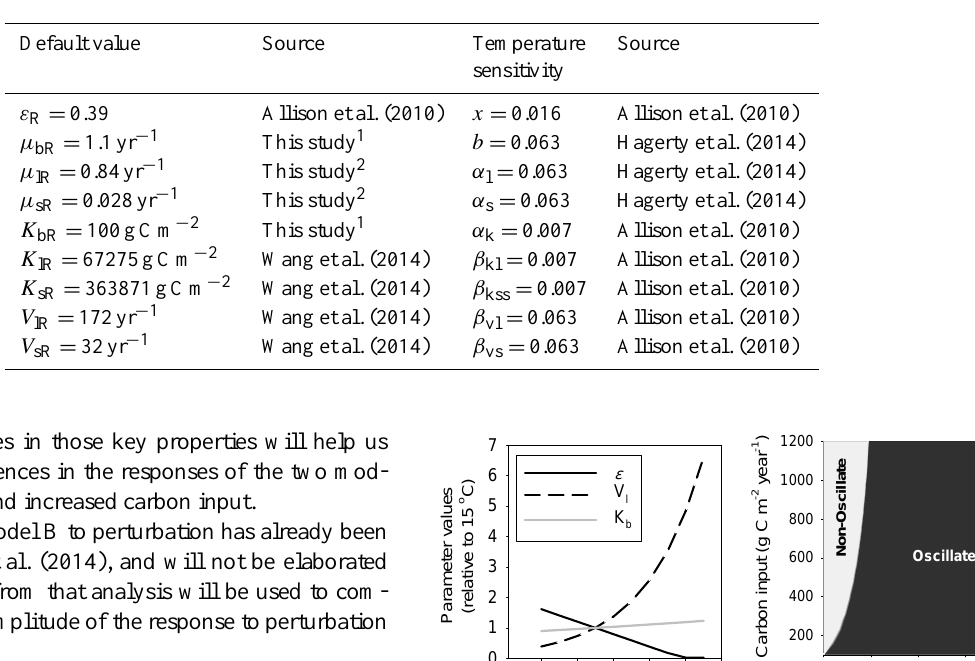
Table 1. Default values of model parameters and their temperature sensitivities ( ◦ C − 1 ) . Four parameters were tuned: 1 tuned using the microbial biomass data measured from a tropical forest site (see Sayer et al., 2011), and 2 tuned against the soil carbon pool size simulated by model B by Wang et al. (2014).